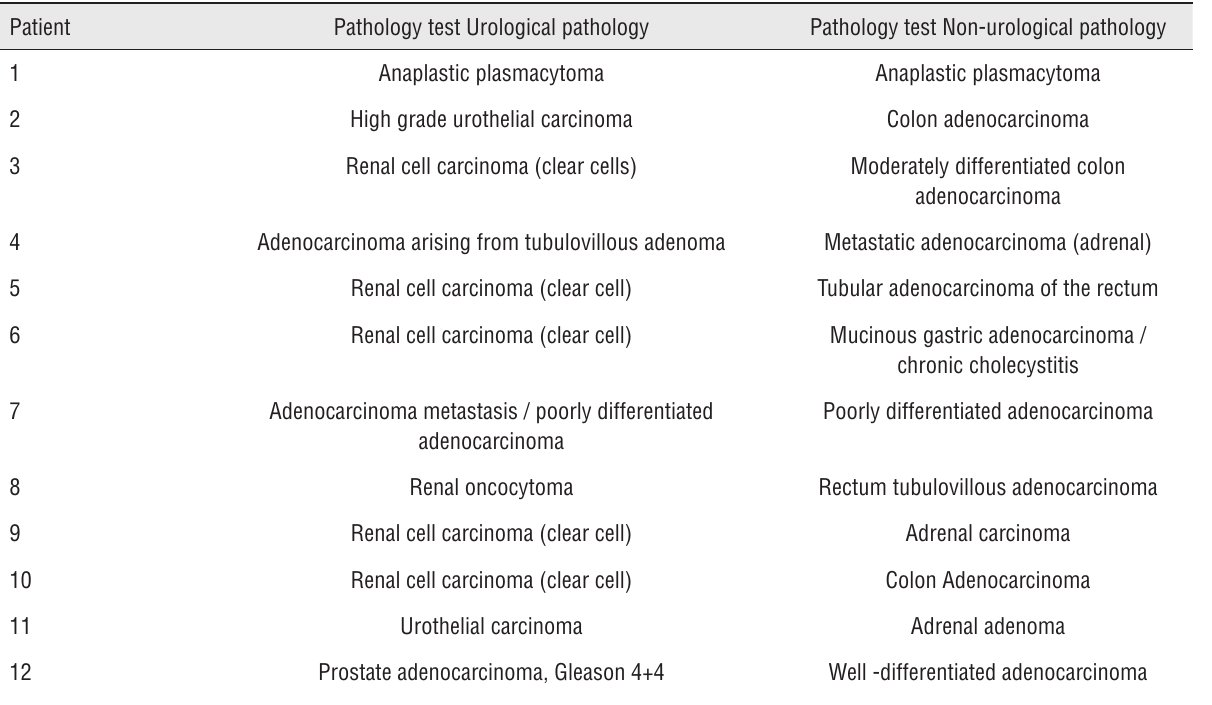
Table 1 - pathological findings regarding urologic and non-urologic diseases.